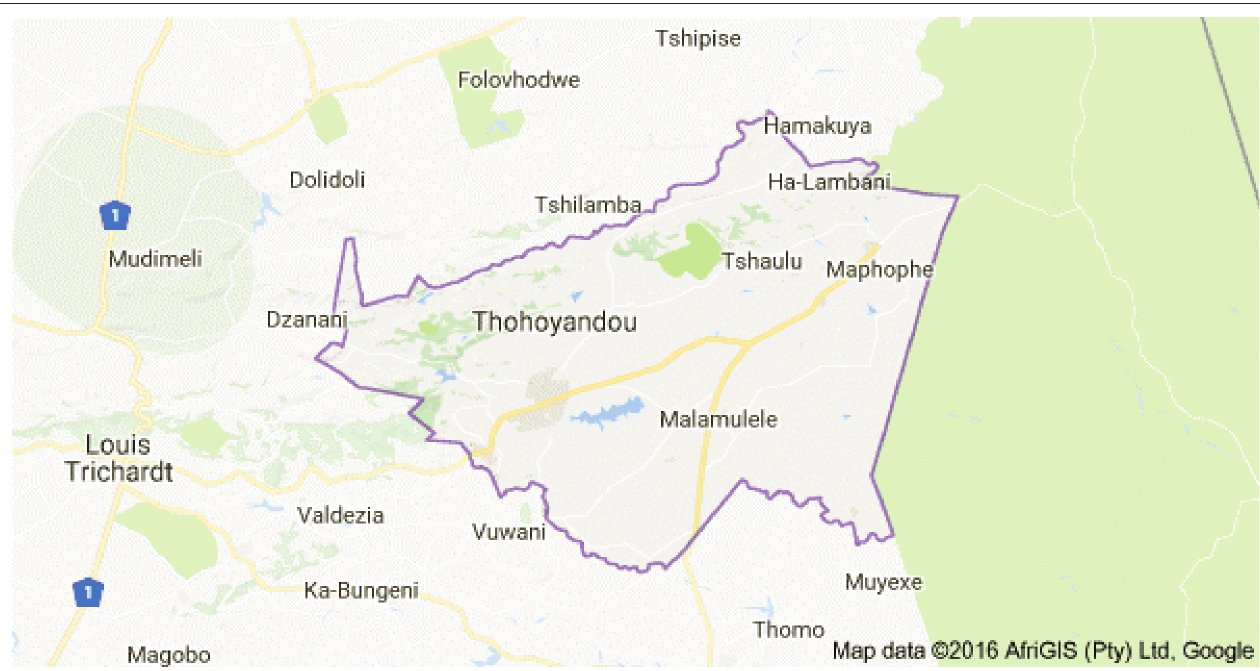
FIGURE 1: Map of Thulamela